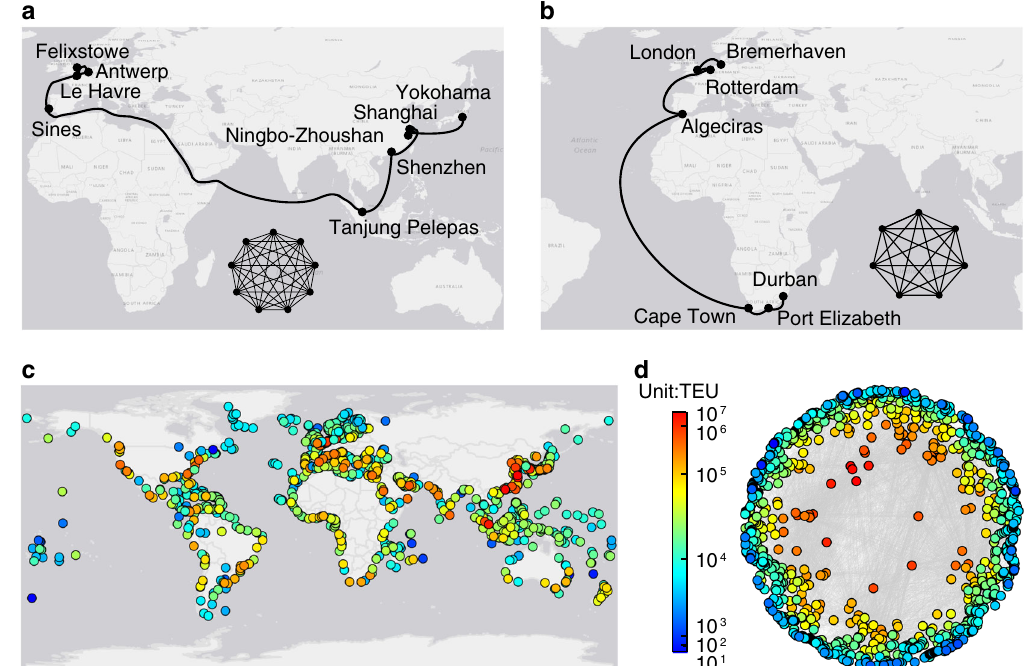
Fig. 1 Construction of the global liner shipping network. With the information on ports of call of world ’ s individual liner shipping service routes, we made each service route a complete graph where any two ports in the service route were connected via an edge. By merging the complete graphs derived from all individual liner shipping service routes, we obtained the GLSN. See “ Methods ” , for details about the adopted data on world ’ s liner shipping service routes and details about the adopted network topology representation method for GLSN construction. In ( a and b ), we show how complete graphs are derived from individual liner shipping service routes, with two examples: an Asia-Europe service route consisting of nine ports ( a ) and an Africa-Europe service route consisting of seven ports ( b ). In ( c and d ), we show ports of the GLSN using a geographical map and show inter-port connections using a hyperbolic layout obtained by coalescent embedding 57 , respectively. The color of nodes corresponds to the traf fi c capacity of ports measured in Twenty-Foot Equivalent Unit (TEU). The coalescent embedding layout clearly points out that TEU gradient is related with the radial coordinate of the hyperbolic